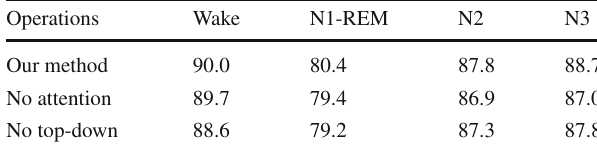
Table 4 The F1 results of part 1 ablation experiments